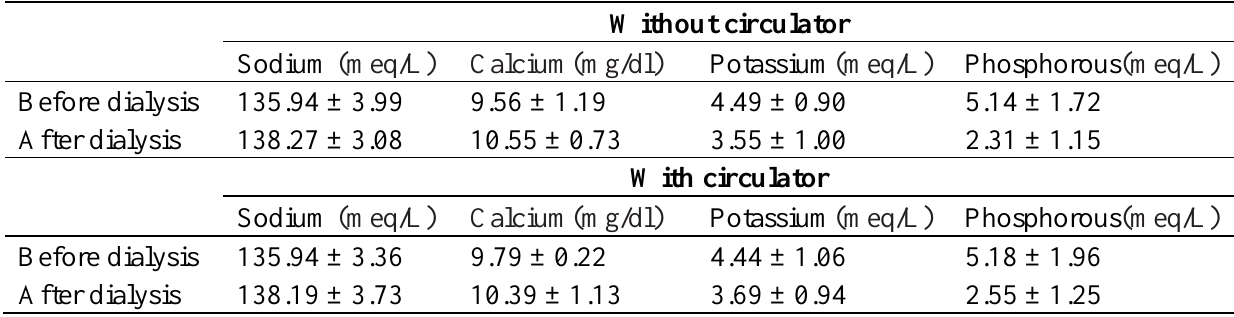
Table 3. Mean and standard deviation of sodium, calcium, potassium, and